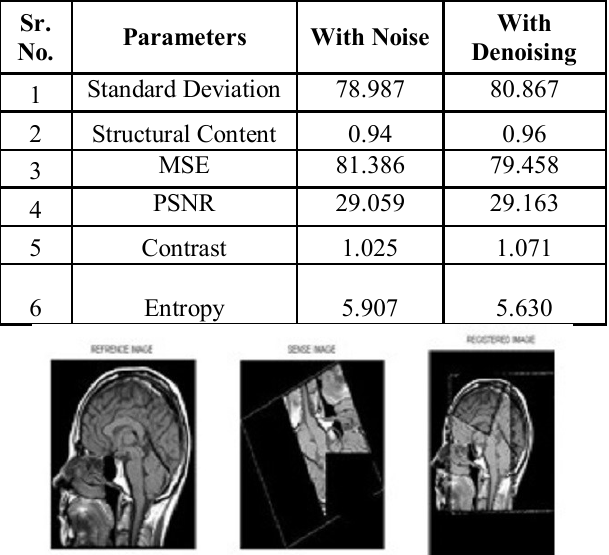
Fig 10. Image Registration for Head CT with rotation without an exact angle. Horizontal movement: - 42, Vertical movement: 7, Rotated